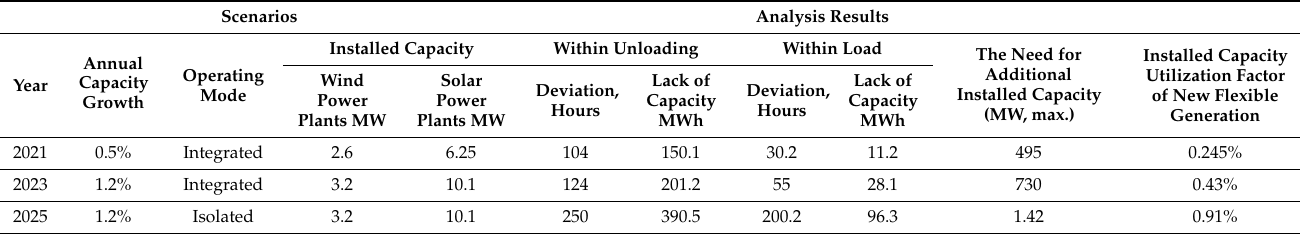
Table 1. Results of analyzing baseline scenarios for the development of corporate renewable energy